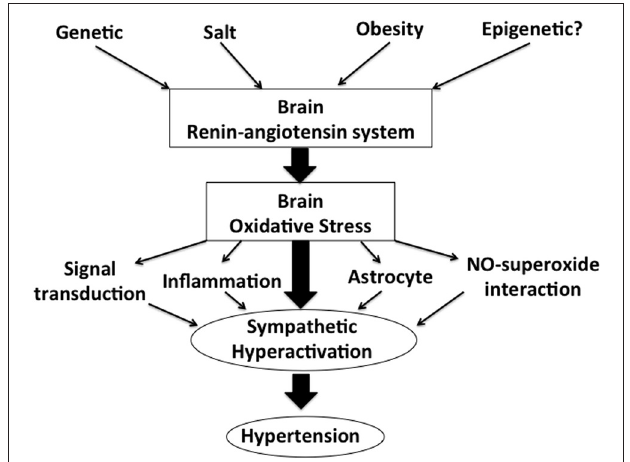
FIGURE 1 | A schema showing our concept in the regulation of sympathetic nerve activity via brain renin-angiotensin system and oxidative